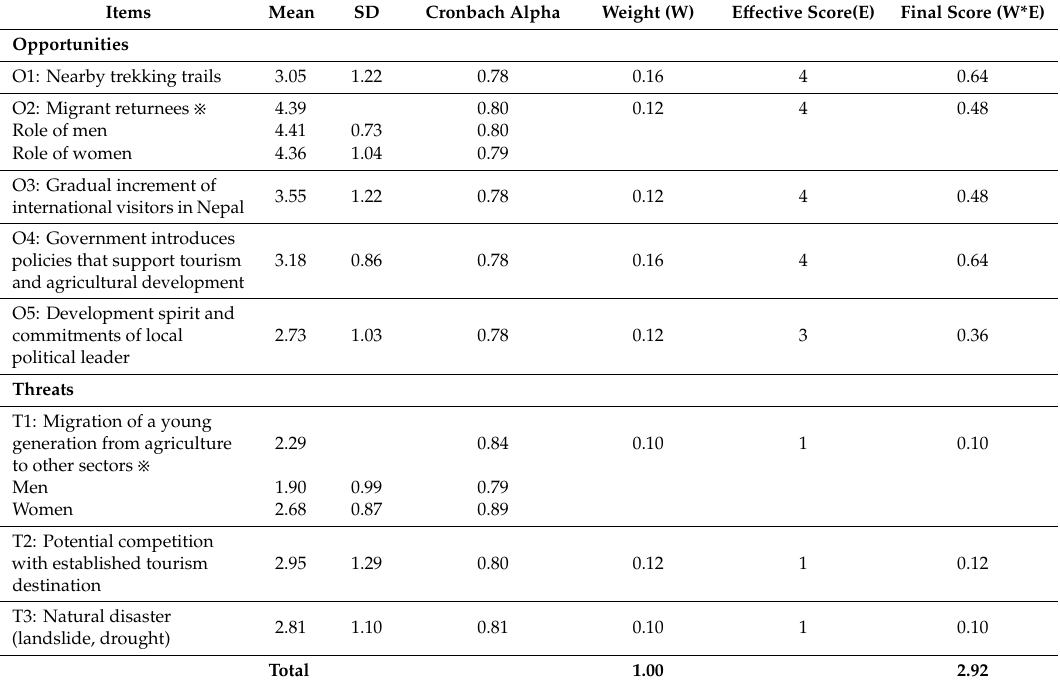
Table 4. The external factor estimation matrix